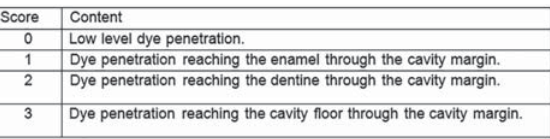
Figure 1- Four grade scale showing degree of micro